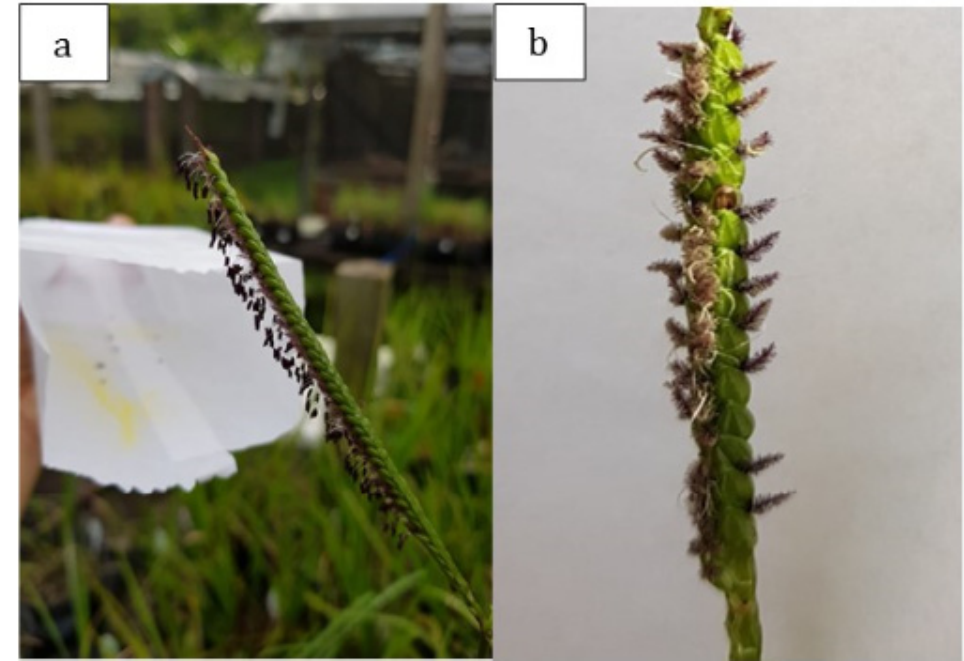
Figure 1. Phases of intraspecific crossing in Paspalum notatum. ( a ) Male parent and pollen collected; ( b ) female inflorescence pollinated after emasculation.